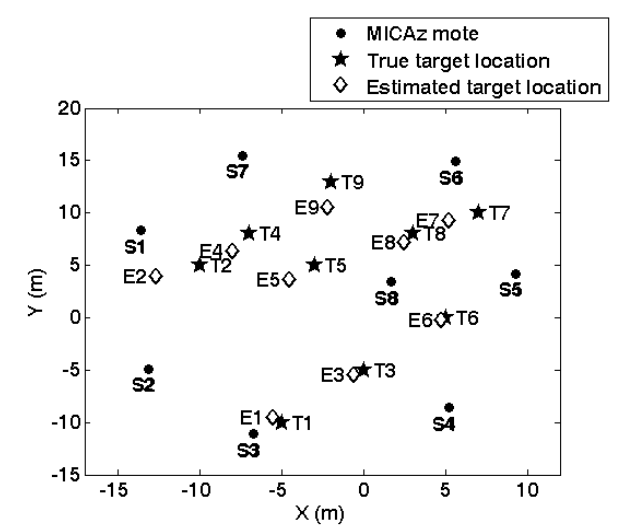
Figure 14. Agent collaborative localization of randomly positioned vehicles in the sensor